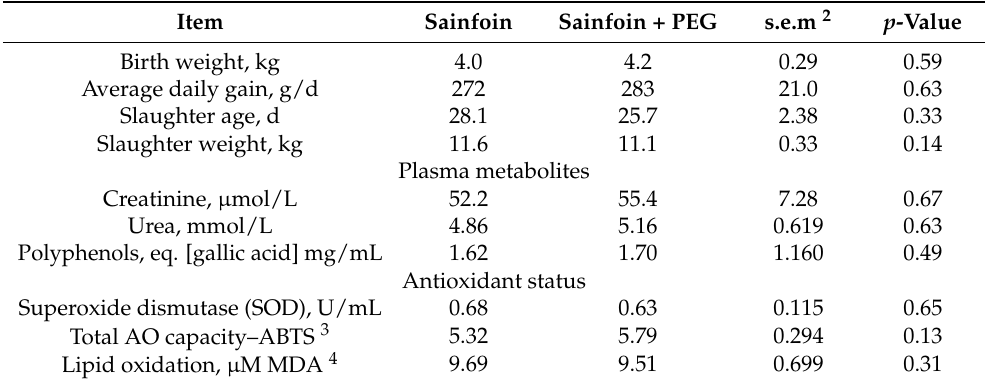
Table 1. Effect of the presence of proanthocyanidins (PAC) in the dams’ diet 1 on the performance, plasma metabolites and antioxidant (AO) status of their suckling lambs. Item